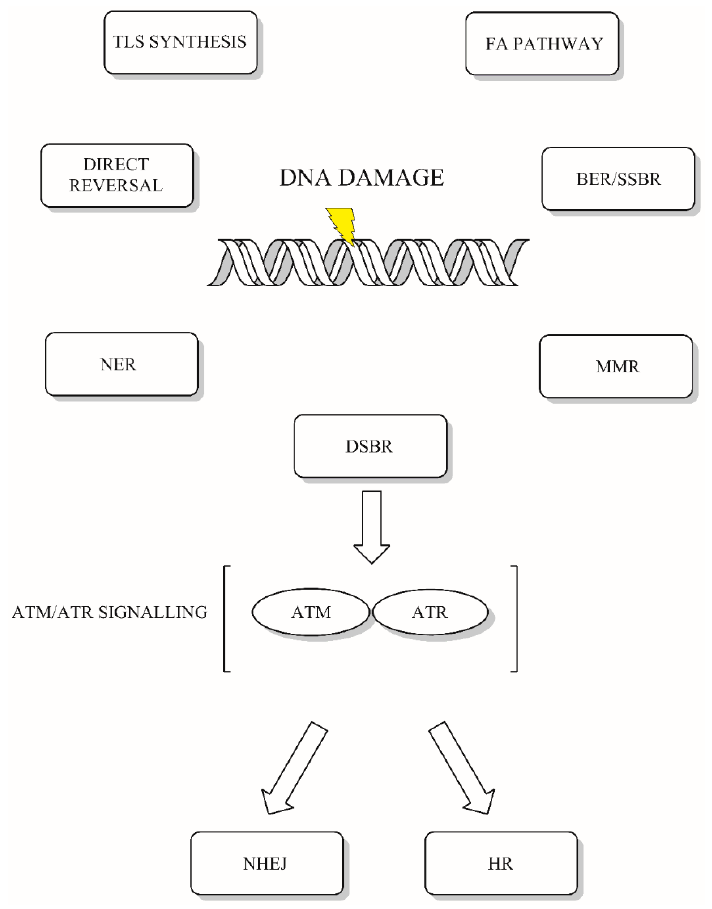
Figure 1. DNA damage response (DDR) in eukaryotes. Eukaryotic DNA response consists of systems of detection, signaling and repair of emerging DNA damage. The main DNA repair systems include direct reversal of damage, base excision repair (BER), nucleotide excision repair (NER), mismatch repair (MMR), Fanconi anemia pathway (FA), trans-lesion synthesis (TLS), single-strand break repair (SSBR) and double-strand break repair (DSBR): non-homologous end joining (NHEJ) and homologous recombination (HR). Double-strand breaks are signaled either by ataxia–telangiectasia and Rad3-related (ATR) or ataxia–telangiectasia mutated protein kinases (ATM) [2].